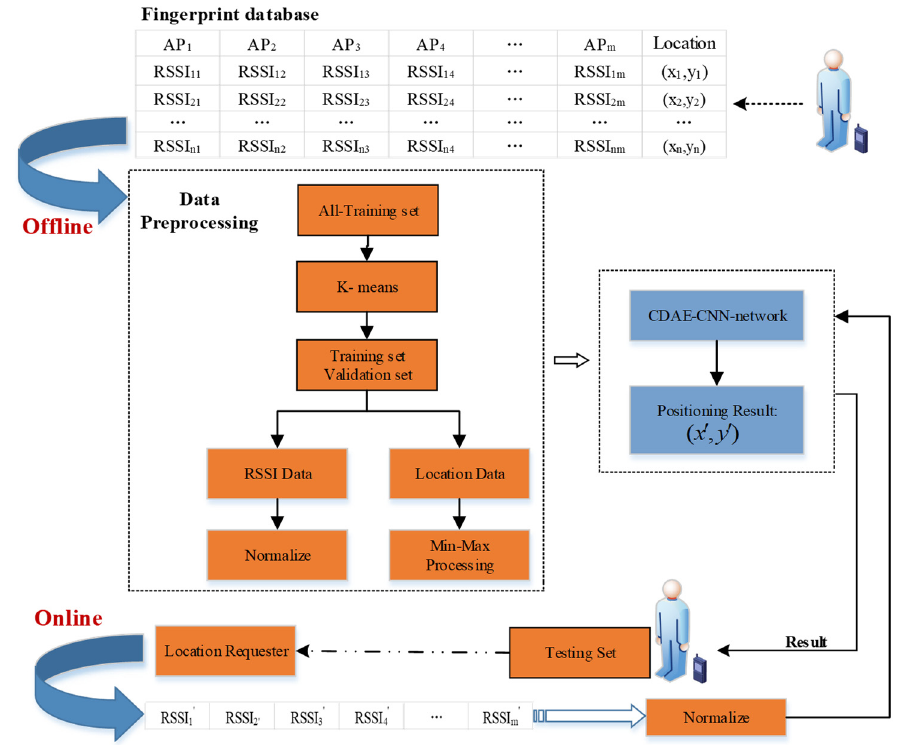
Figure 2. System architecture of CCpos.